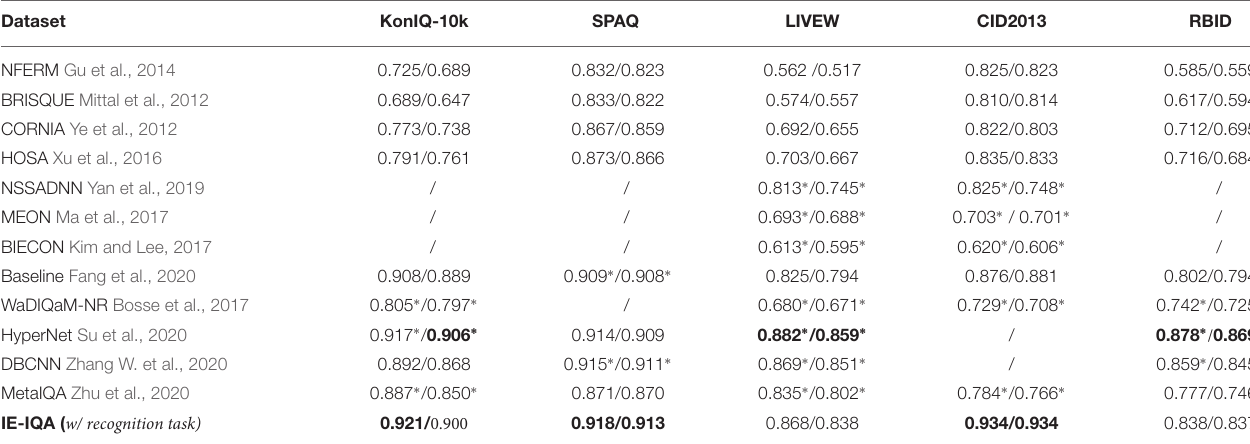
TABLE 3 | Pearson’s linear correlation coefficient (PLCC)/Spearman’s rank order correlation coefficient (SRCC) results on intra-dataset tests.